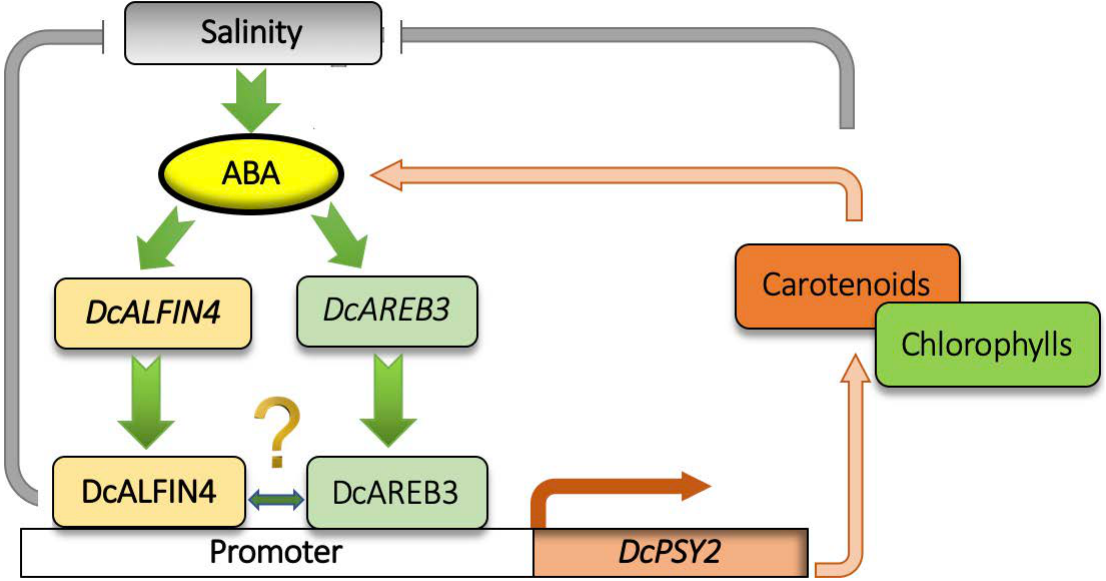
Figure 5. Proposed model for the role of DcAL4 in the induction of DcPSY2 expression during salt stress in leaves. Salt stress and ABA produce an increment in the expression of DcPSY2 and DcAREB3 in carrot leaves (This study and [8]), and DcAL4 in leaves (this study). The expression of DcPSY2 is induced by ABA as a positive feedback mechanism accomplished by the direct binding of DcAL4 (this study) and DcAREB3 [8] transcription factors. The upregulation of DcPSY2 leads to an increment in carotenoids and chlorophylls, which together promote salt stress tolerance